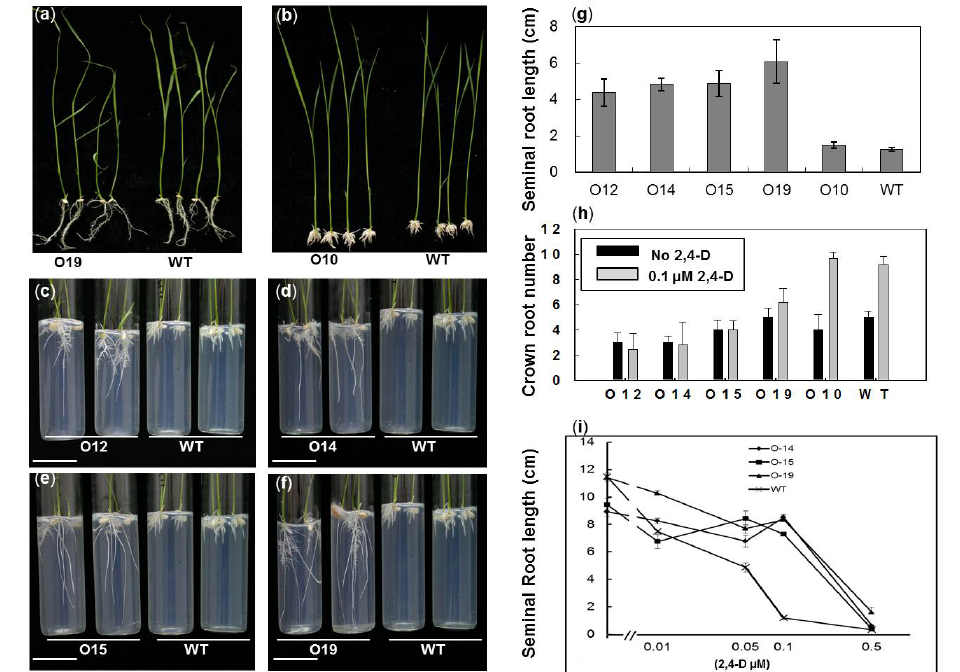
3. Root elongation assay of OsIAA4 -overexpressing plants under 2,4-D treatment. ( a ) Transgenic plants and wild-type (WT) Zhonghua 11 grown in normal Murashige and Skoog (MS) medium; ( b ) non-overexpressing line (O10) and WT plants grown in MS medium with 0.1 μ M 2,4-D; ( c – f ) Transgenic (O12, O14, O15, and O19), non-overexpressing transgenic (O10), and WT plants grown in MS medium with 0.1 μ M 2,4-D; ( g ) Quantification of seminal root length in (c–f) ( t -test, p < 0.01). scale bars in c–f = 29 mm; ( h ) Quantification of crown root number of transgenic (O12, O14, O15, and O19), non-overexpressing transgenic (O10), and WT plants grown in MS medium with or without 0.1 μ M 2,4-D; ( i ) Dose responses of OsIAA4 -overexpression (O14, O15, and O19) and WT plants to 2,4-D. Error bars indicate SE, n =